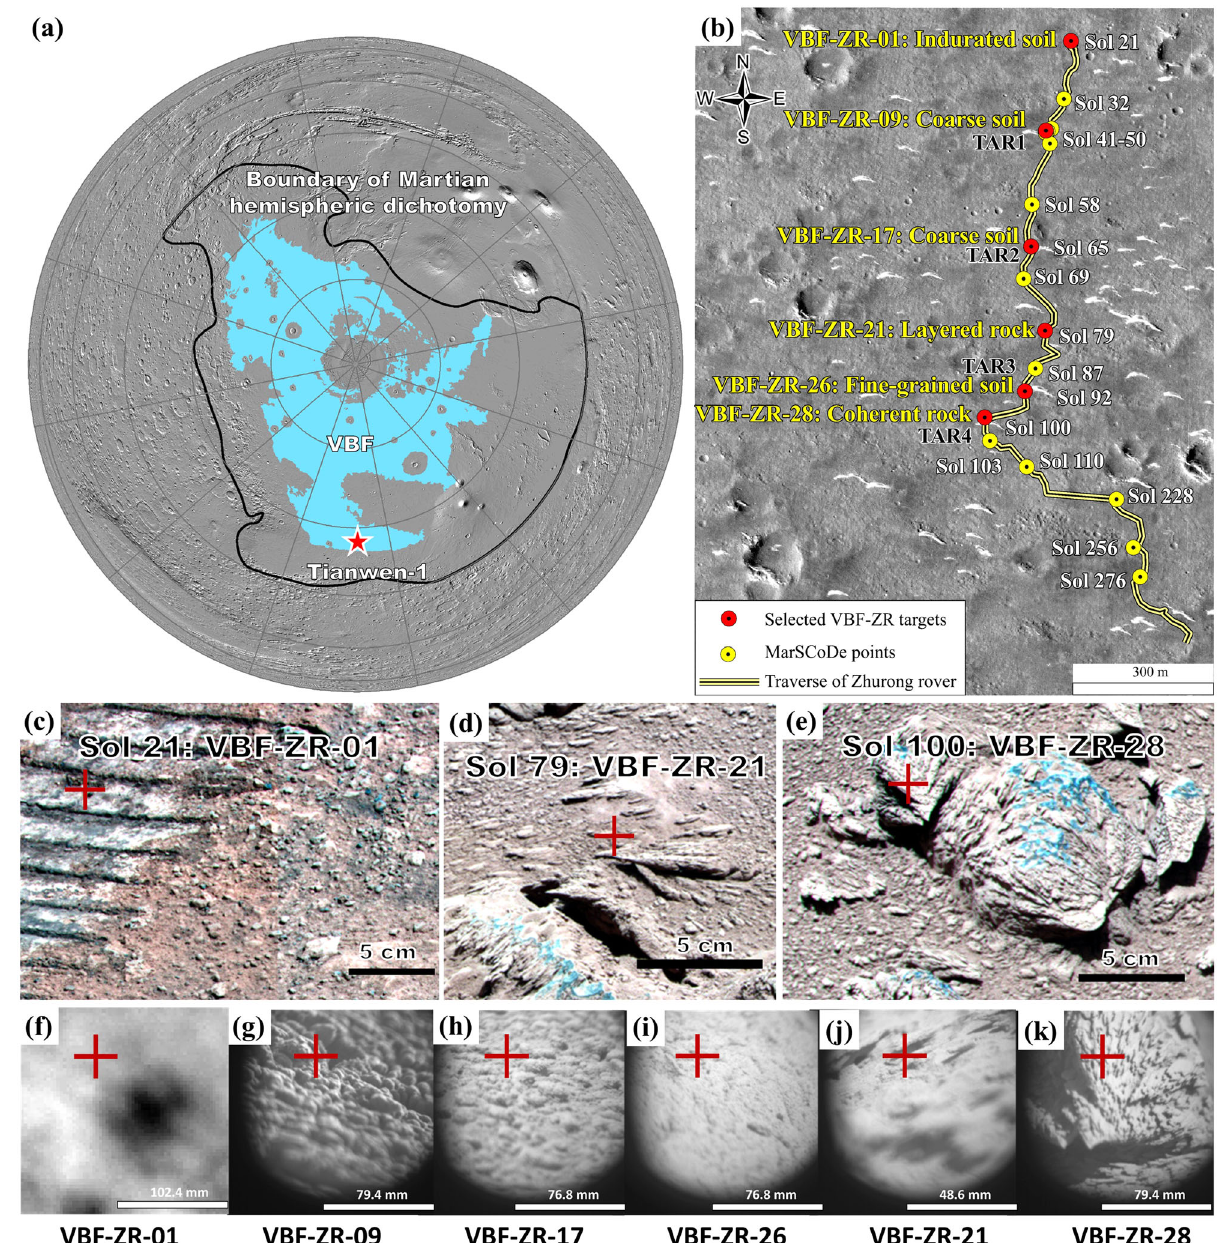
Fig. 1 Landing site, traverse map, and MI images of six VBF-ZR targets. a Distribution map of the VBF unit on the Northern Plains of Mars. The map base is a Mars Orbiter Laser Altimeter (MOLA) shaded-relief image. b Traverse map of the ZR rover up to sol 300 overlain on the base image of High- Resolution Imaging Camera (HiRIC) data. The HiRIC raw data is provided by China National Space Administration. The yellow points represent the locations of MarSCoDe targets, and the red points indicate the locations of six VBF-ZR targets discussed in this study. c – e The images of VBF-ZR-01, VBF- ZR-21, and VBF-ZR-28 targets collected by the Multispectral Camera (R 650 nm, G 525 nm, B 480 nm). f The MI images of VBF-ZR-01 target (the fi rst target detected at the landing site, 64 × 64 pixels), g , h coarse-grained soils (VBF-ZR-09 at TAR1, VBF-ZR-17 at TAR2, 1024 × 1024 pixels), i fi ne-grained soils (VBF-ZR-26 at TAR3, 1024 × 1024 pixels), j a layered rock (VBF-ZR-21, 1024 × 1024 pixels), and k a coherent rock (VBF-ZR-28 at TAR4, 1024× 1024 pixels). In these MI images, the red cross indicates the laser-ablated